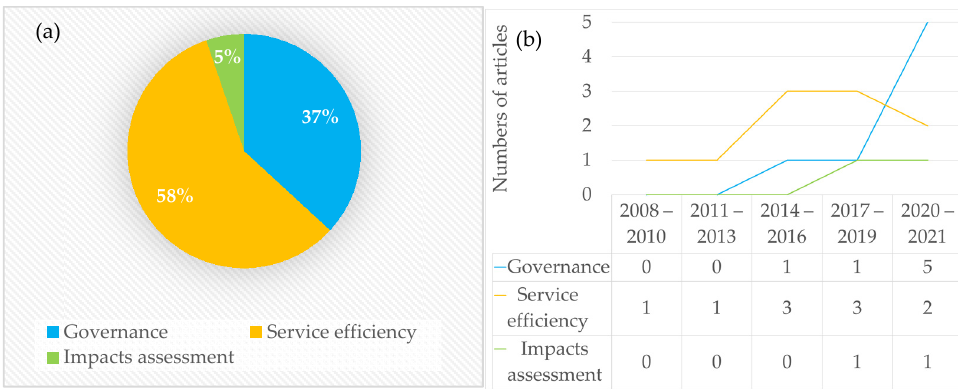
Figure 3. ( a ) Topic coverage IMC and water; ( b ) the evolution of the number of scientific articles IMC and water.